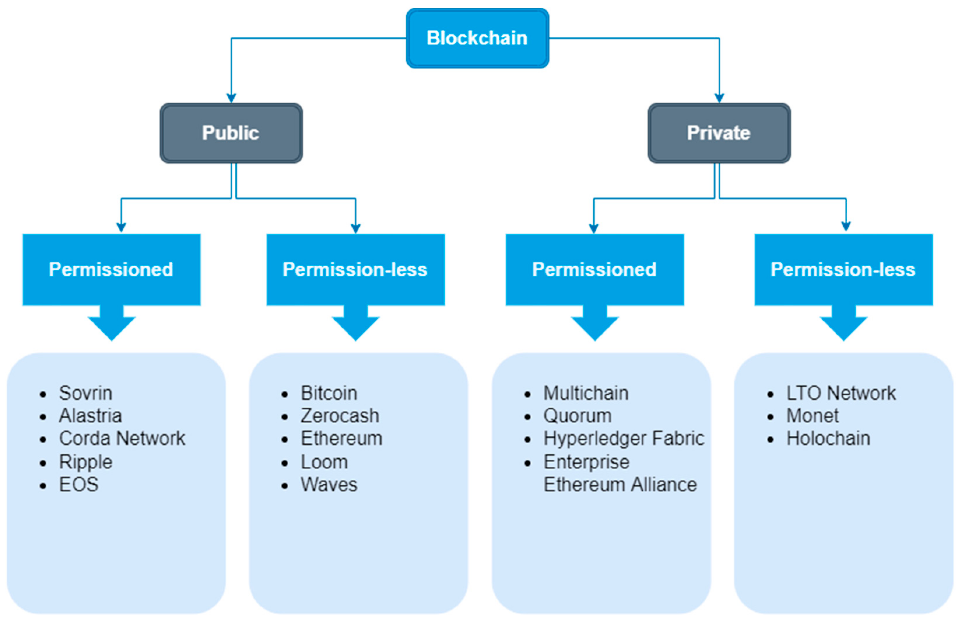
Figure 6. Types of blockchain.